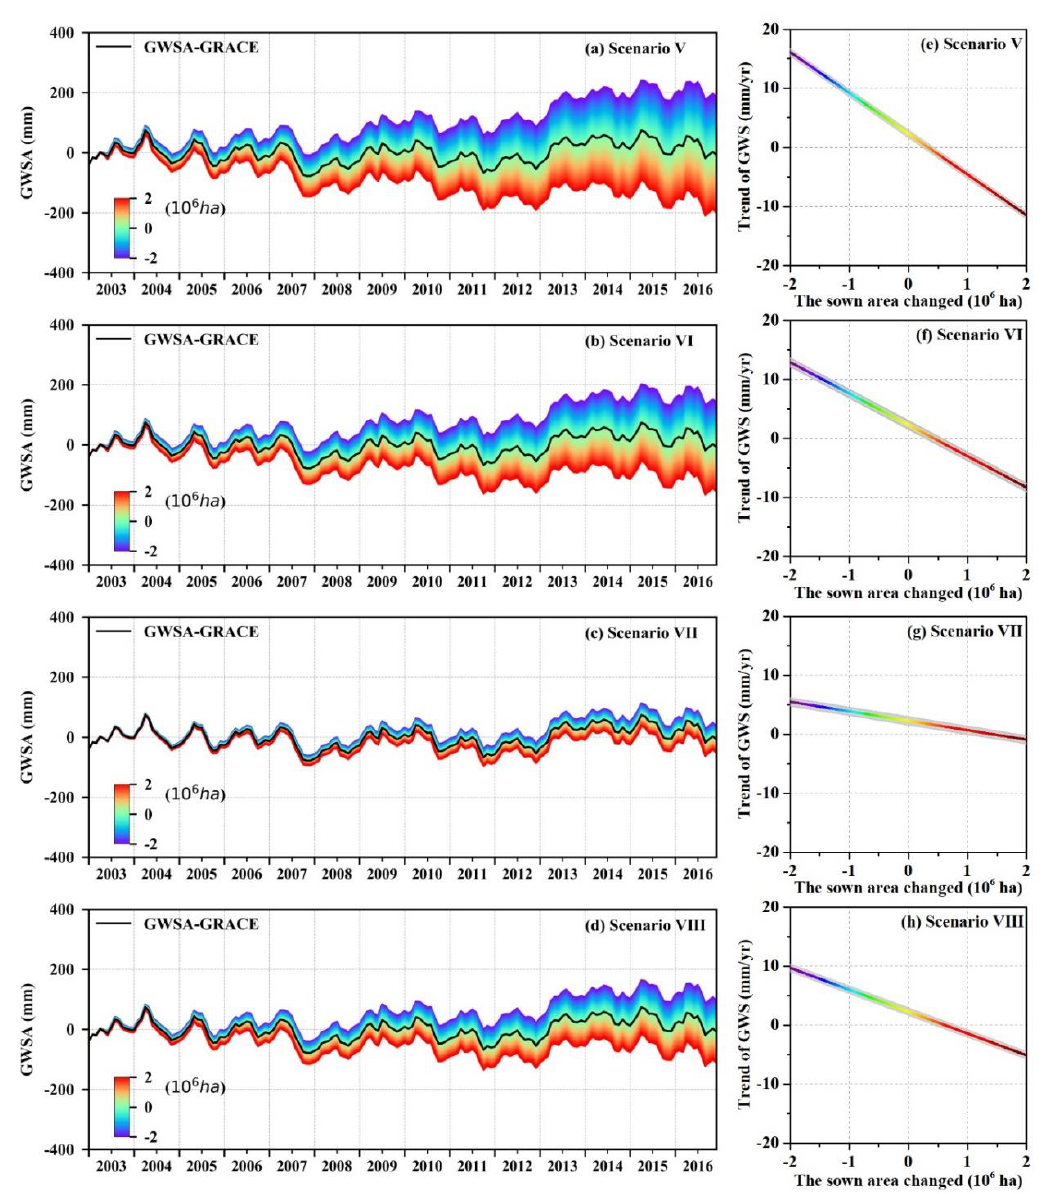
Figure 11. The 2003–2016 monthly GWSA ( a – d ) and GWS trend ( e – h ) from GRACE and scenario simulation in the NECP. Scenarios V–VII refer to changes in the sown area of rice and maize (V), rice (VI) and maize (VII). Scenario (VII) refers to increasing (decreasing) the sown area of rice while decreasing (increasing) the sown area of maize by the same amount. The color shading bar represents the range of rice and maize sown area (V), rice sown area (VI)), maize sown area (VII), and rice sown area (VIII) changes. The grey shaded line is the error trend in GWSA ( e – h ).